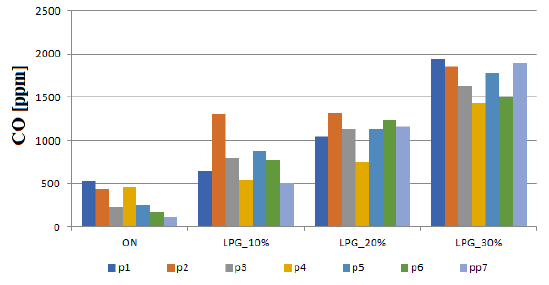
Fig. 12. The comparison of CO emissions